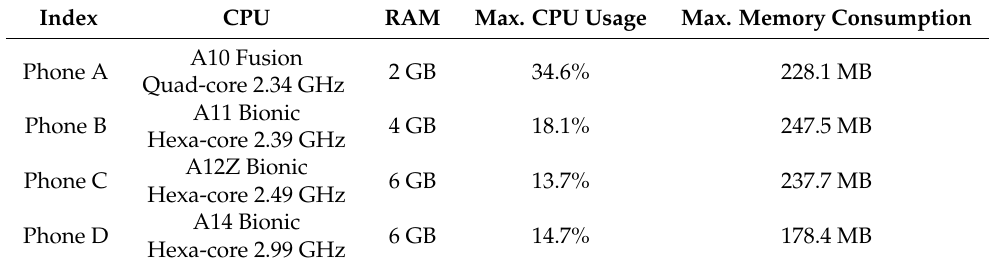
Table 8. Resources consumption of the developed system in the situation of